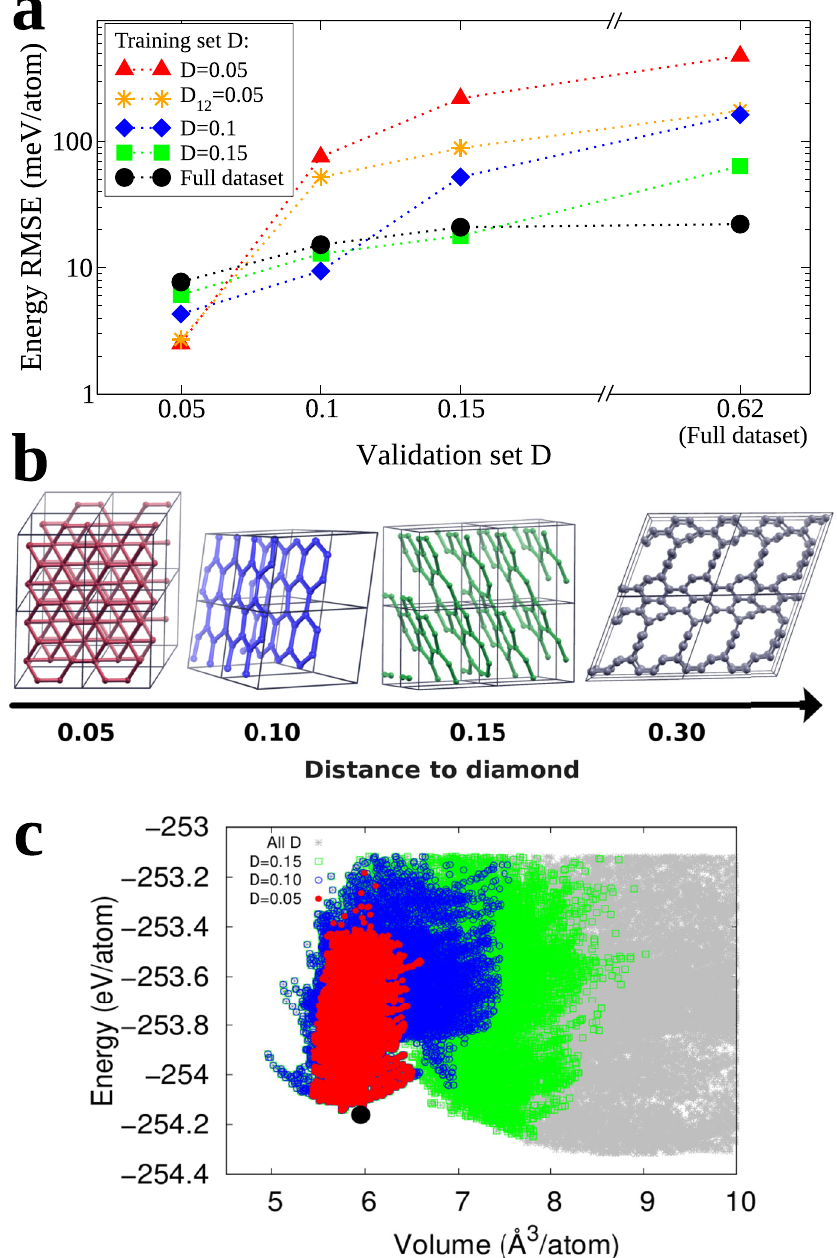
Fig. 7 The relationship between model transferability and the similarity of training and validation datasets. a Validation error of networks trained on different datasets as a function of the distance of the validation set from diamond. Numerical values are given in the Supplementary Table I for energies and forces. b Representative structures at given distances from diamond, the reference structure. The structures at 0.05 or lower are recognizably related to the reference, while at 0.10 and 0.15 compressed and/or defected layered structures are visible. At 0.30 and above, con fi gurations with several double bonds and carbon chains appear. c Energy per atom as a function of volume for structures in the dataset, colored according to their distance cutoff D from diamond. The black dot corresponds to the reference diamond structure. The complete dataset includes structures with larger volume that are omitted here for clarity. The complete volume range is given in the Supplementary Fig.